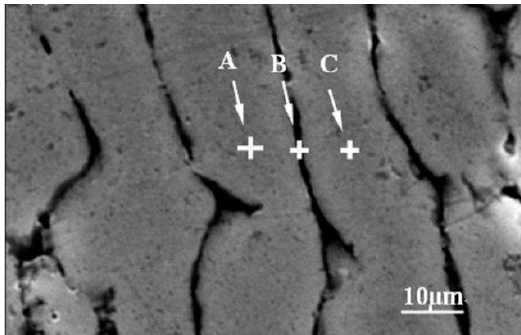
Figure 11. Positions of energy dispersive X-ray spectrometry (EDX) analysis of the thixoformed part soaked for 10 min at 590 °C. Table 1. Energy dispersive X-ray spectrometry (EDX) results in different locations of the thixoformed part soaked for 10 min at 590 ◦ C.